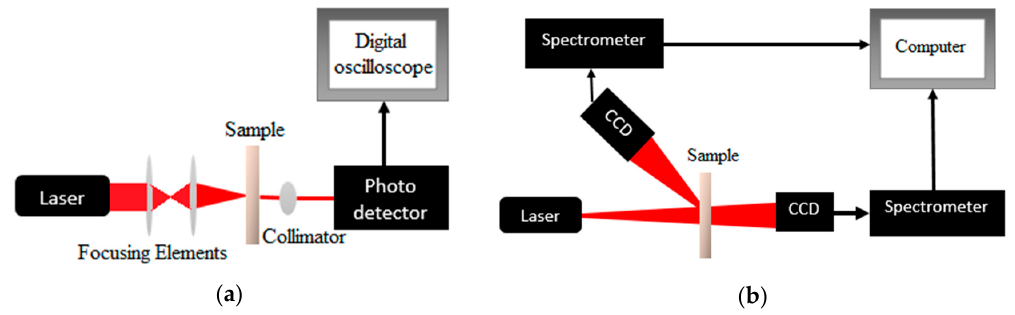
Figure 1. The schematic diagram of the proposed setup: ( a ) collimated transmission measurement; ( b ) diffuse reflection and transmission measurement ( b ) diffuse reflection and transmission